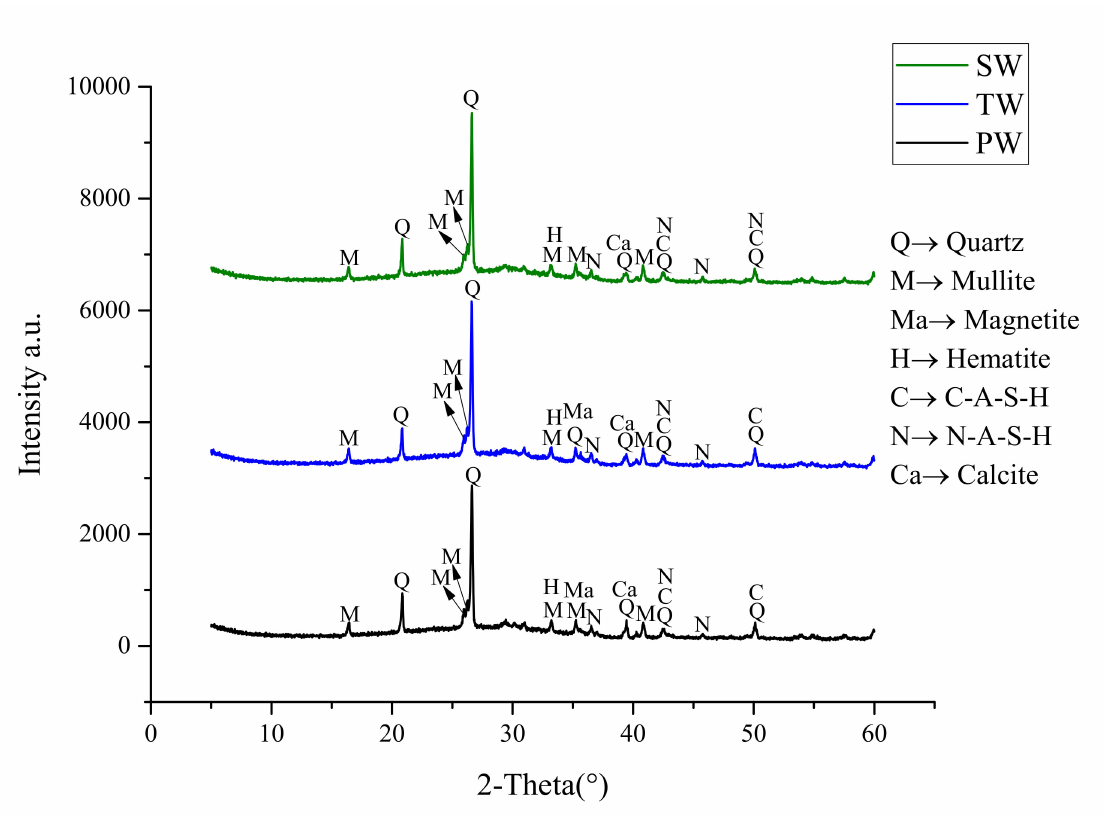
Figure 4. X-ray di ff ractometry (XRD) spectra of AAM produced with di ff erent types of